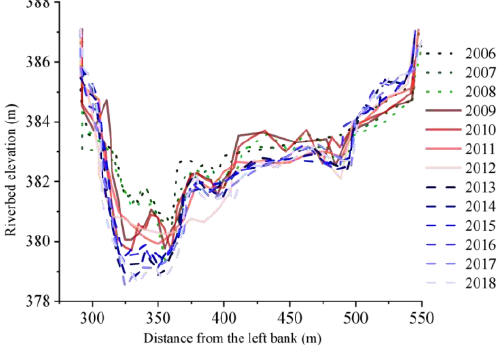
Figure 2. 2006 – 2018 Xianyang station post − flood cross − section. Figure 2. 2006–2018 Xianyang station post-flood cross-section.